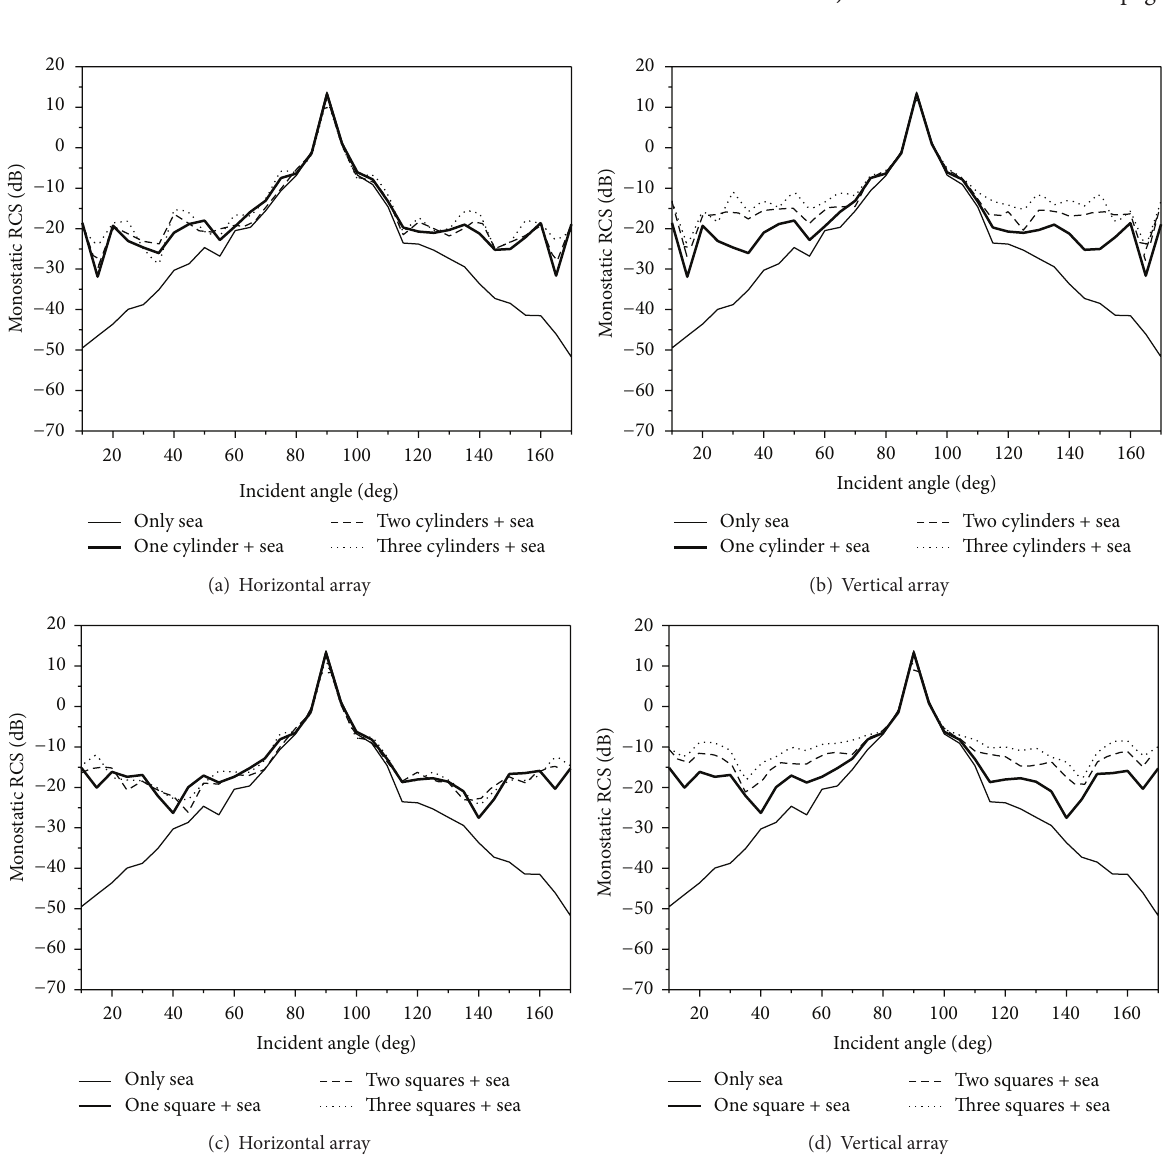
Figure 7: Monostatic RCS of objects of different number over the PM rough sea